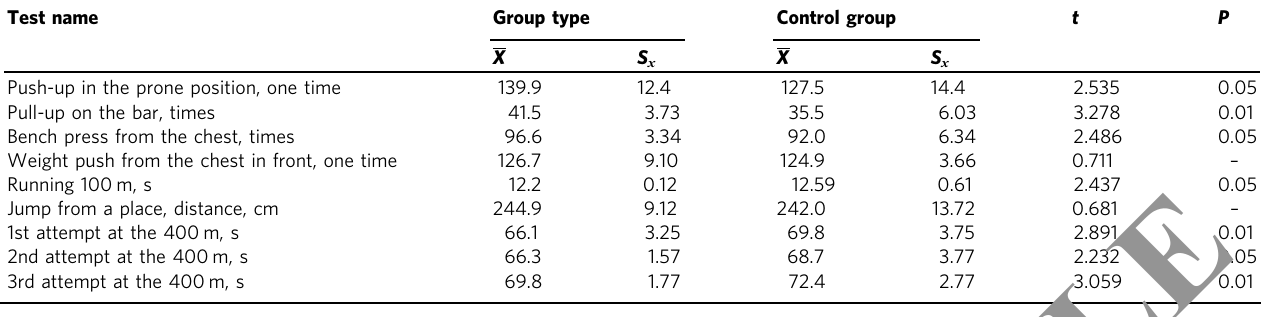
Table 3 Recorded differences between the average physical activity parameters for the experiment and control groups before and after the experiment.